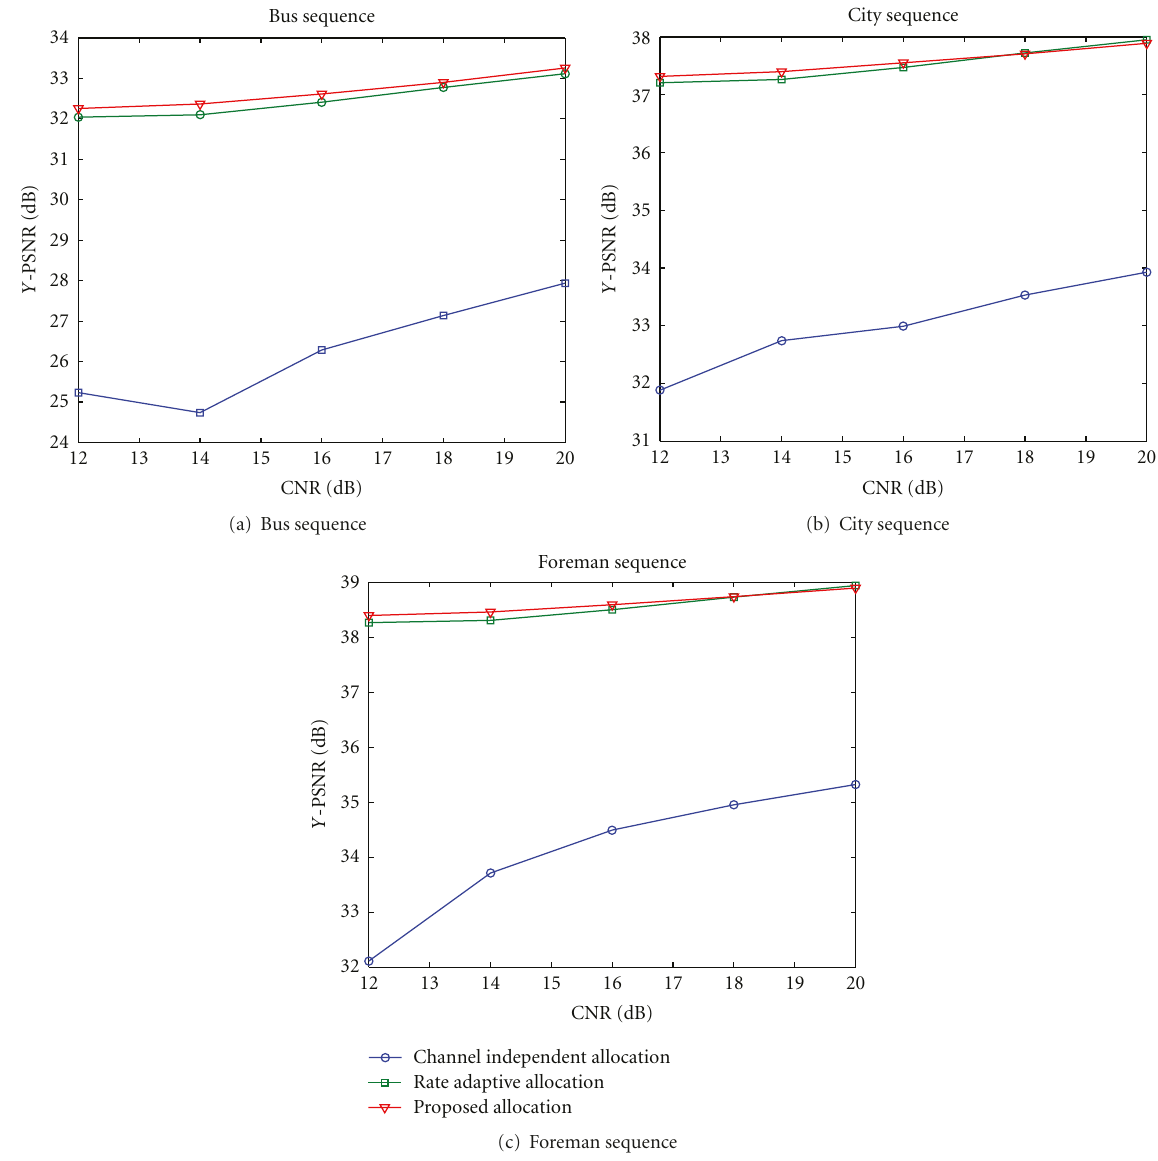
Figure 7: Y-PSNR plot for with di ff erent resource allocation